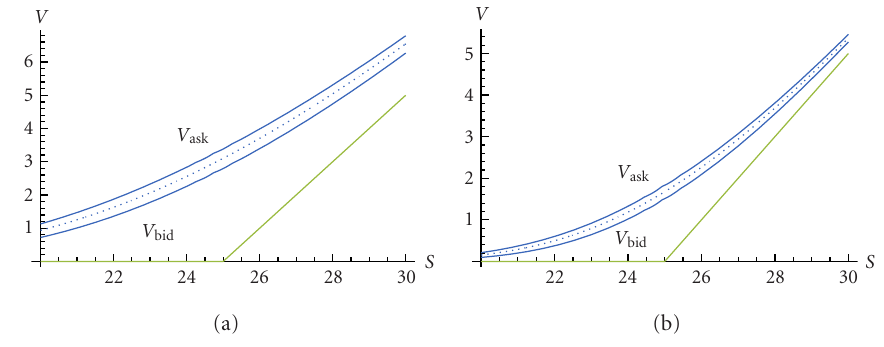
Figure 5.2. A comparison of bid and ask option prices computed by means of the RAPM model. The dotted line in the middle is the option price computed from the Black-Scholes equation. We chose (a) σ = 0 . 3, µ = 0 . 2, r = 0 . 011, E = 25, and T = 1 and (b) T = 0 .